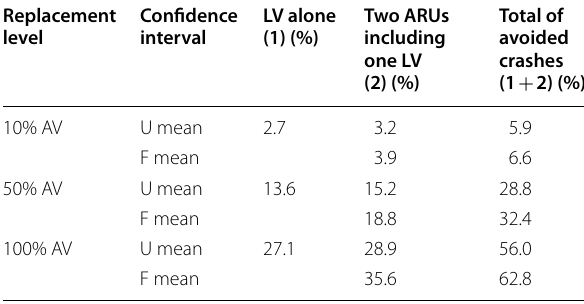
Table 4 Average percentage* of avoided crashes for fatal